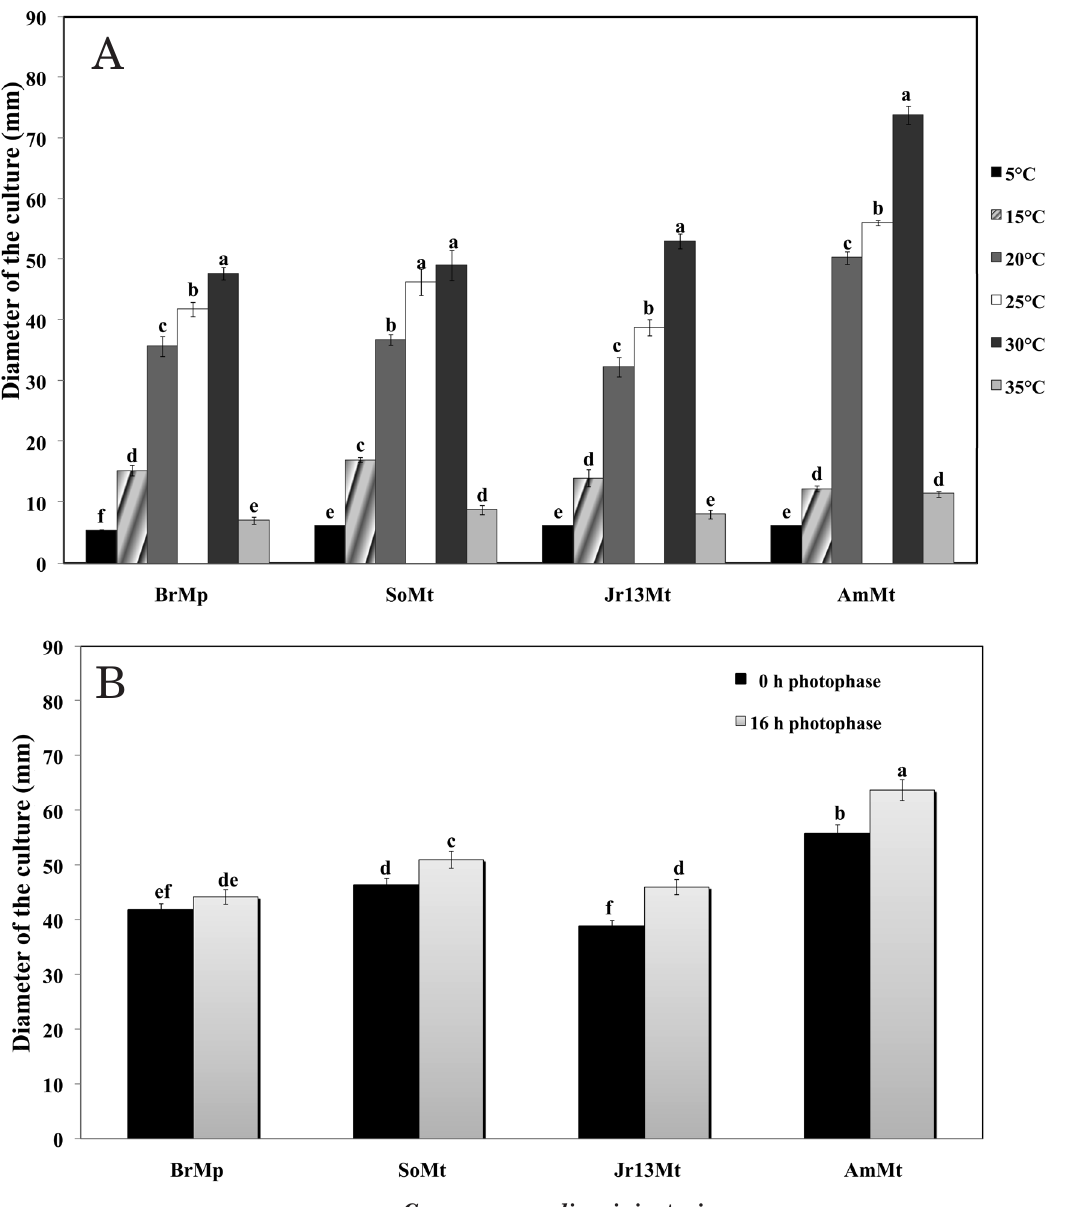
Figure 2. Growth of four strains of Cercospora medicaginis at different temperatures (A) and with different lighting (B). ulation of conidia in BrMp, Jr13Mt and AmMt, while for SoMt it was better at pH 4–5. For all four strains, production of conidia was lowest at pH 6–7 (Figure 3B). No significant correlation was found between growth and conidium production of any of the four C. medicaginis strains and the medium, the photoperiod or the